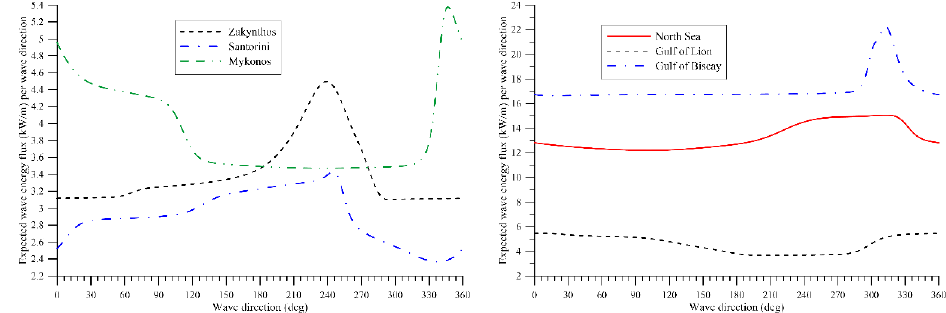
Figure 6. Expected value of wave energy flux as function of wave direction at the examined locations. Left panel: Mykonos, Santorini, and Zakynthos. Right panel: Gulfs of Lion and Biscay and North Sea.